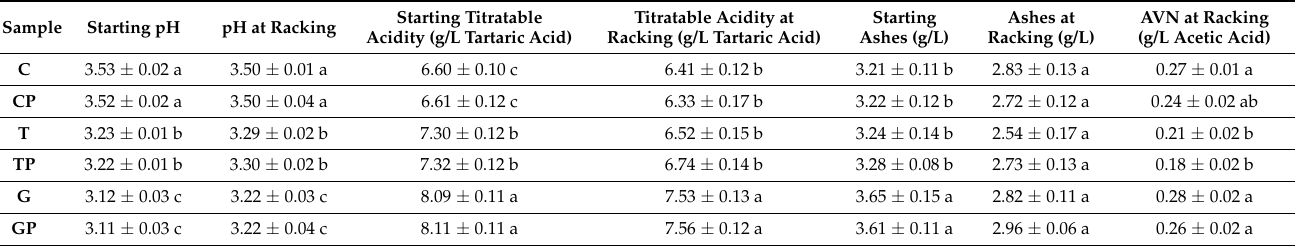
Table 4. Values of starting pH, pH at racking, starting titratable acidity, titratable acidity at racking, starting ashes, ashes at racking, and AVN at racking. C = Castellina, G = Gaiole, T = Tavarnelle, CP = Castellina plantarum, GP = Gaiole plantarum, and TP = Tavarnelle